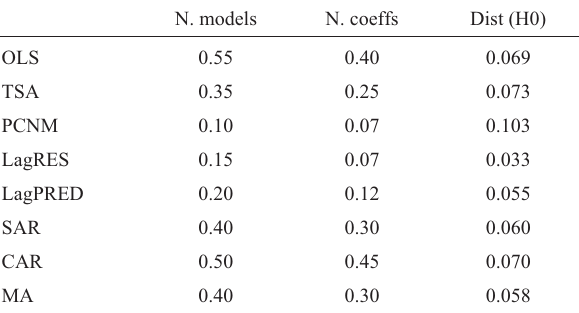
Table 2 - The same analyses shown in Table 1, but regressing allele fre- quencies evolving under a pure isolation-by-distance process against two out of three explanatory variables (removing human